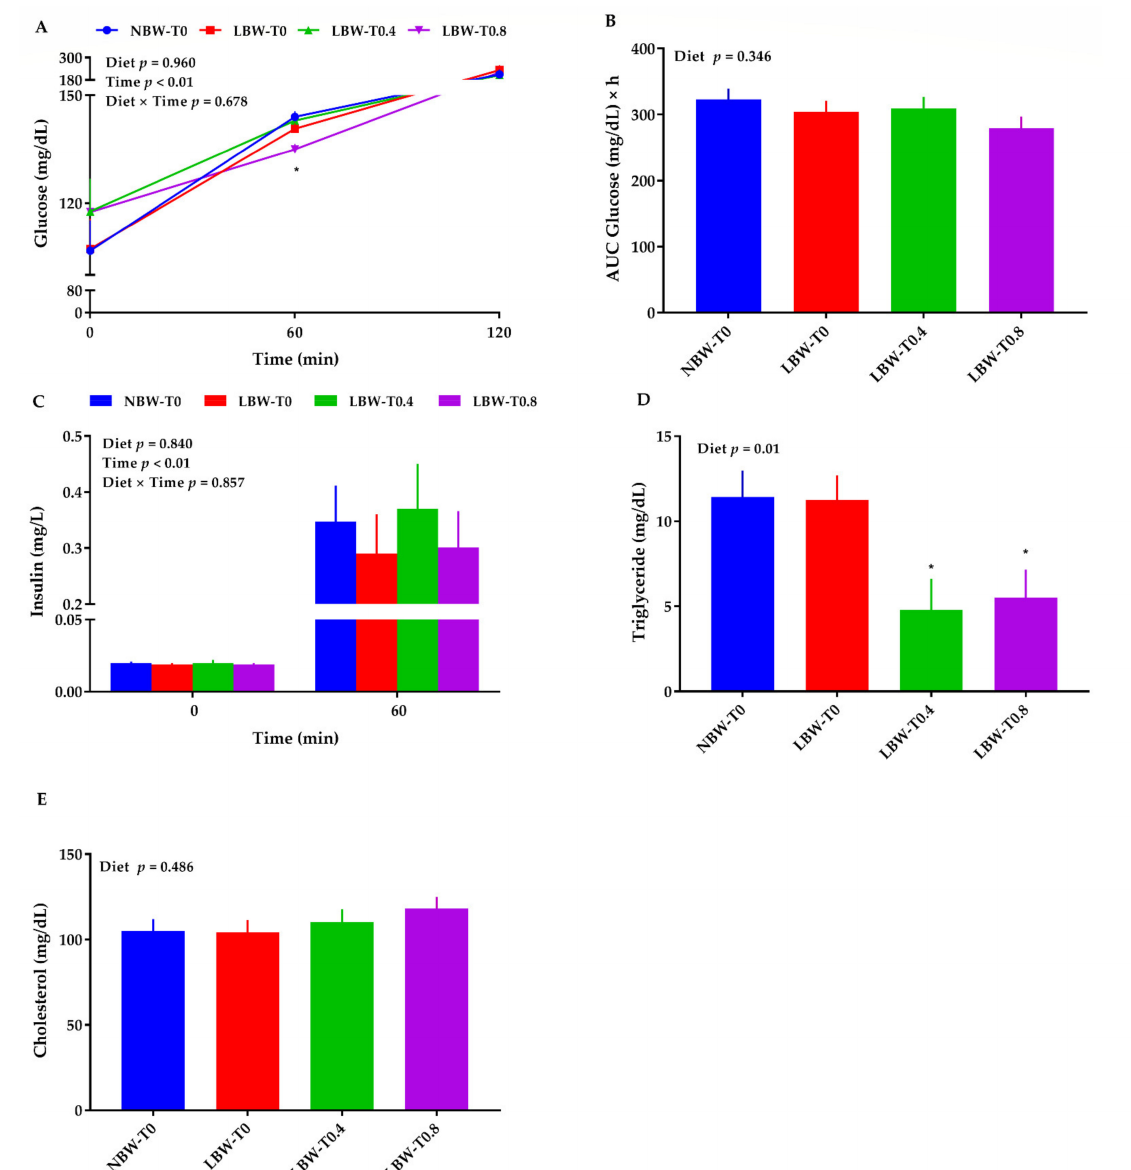
Figure 5. Effect of dietary L-tryptophan supplementation on plasma metabolite concentrations in low-birthweight neonatal pigs. ( A ) glucose, ( B ) area under the curve (AUC) for glucose, ( C ) insulin, ( D ) triglyceride, and ( E ) cholesterol. NBW-T0, normal-birthweight piglets fed a basal diet without supplemented L-tryptophan (Trp); LBW-T0, low-birthweight piglets fed a basal diet without supplemented Trp; LBW-T0.4, low-birthweight piglets fed a diet supplemented with 0.4% Trp; and LBW-T0.8, low-birthweight piglets fed a diet supplemented with 0.8% Trp. n = 8 for NBW-T0, LBW-T0, and LBW-T0.8, and n = 7 for LBW-T0.4. * p ≤ 0.05 vs. LBW-T0. The values are the means ±